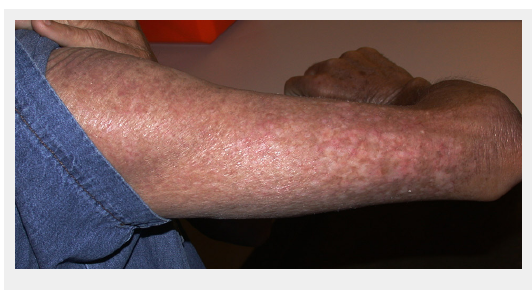
Morbilliform exanthema of acute GvHD of the skin including the palma manus.